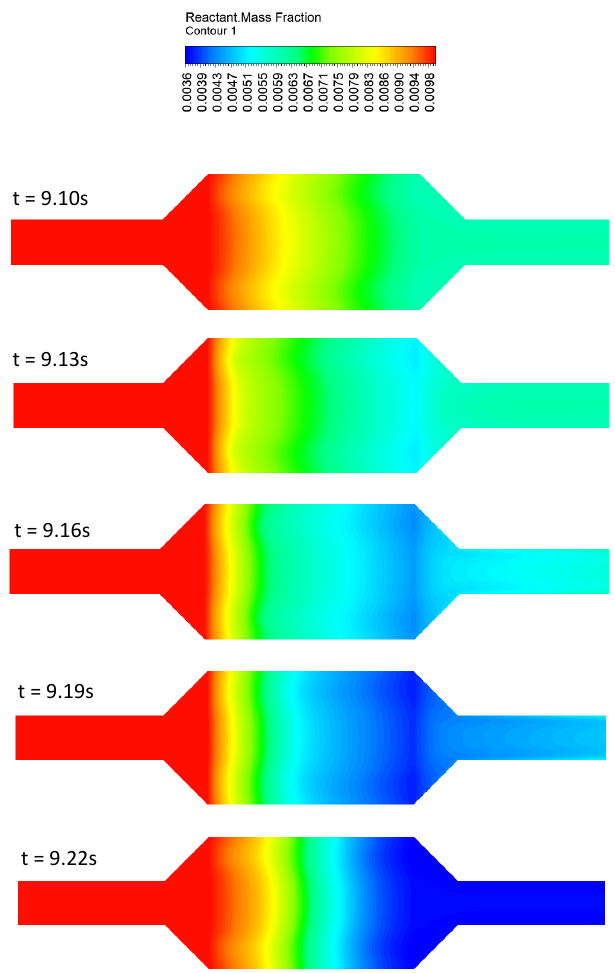
Figure 5. Five snapshots of the reactant mass fraction fields for case 2 (at t = 9.10 s, t = 9.13 s, t = 9.16 s, t = 9.19 s, and t = 9.22 s). The inlet velocity decreases from 10 m/s to 5 m/s at t = 9.10